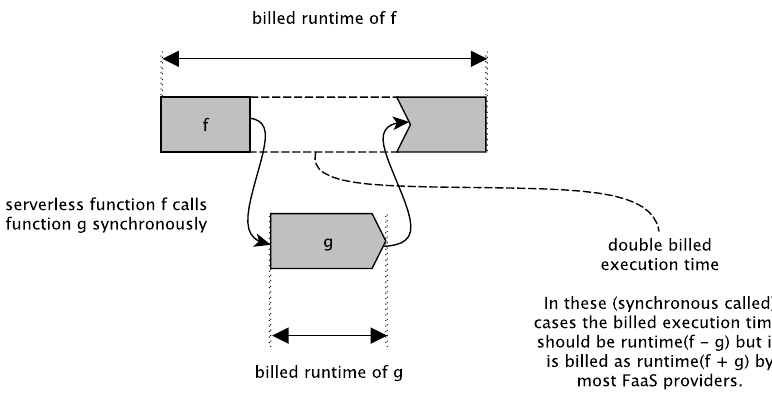
Figure 6. The double spending problem resulting from the Serverless trilemma